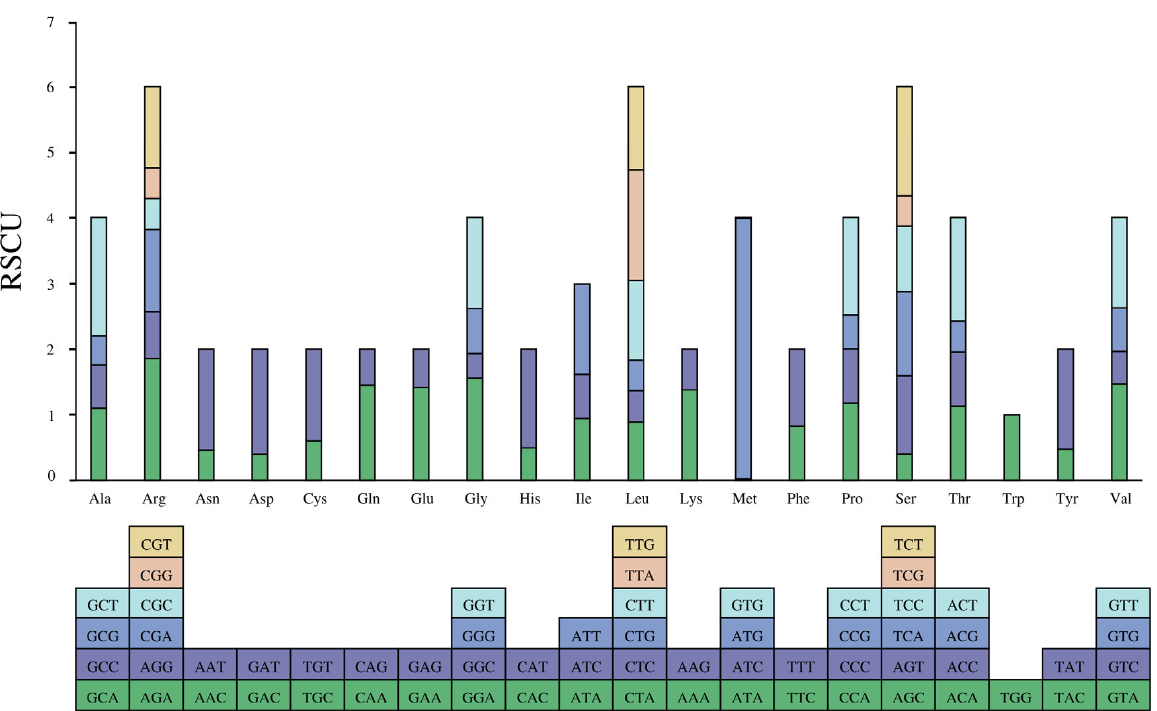
Figure 3. Relative synonymous codon usage of amino acids in cpDNA genome of B. schreberi . Rectangles with different colors refer to different amino acids codons, and RSCU value depends on codon repeating times. Arg, Leu, Ser all have six codons, while Trp has the least one codon.